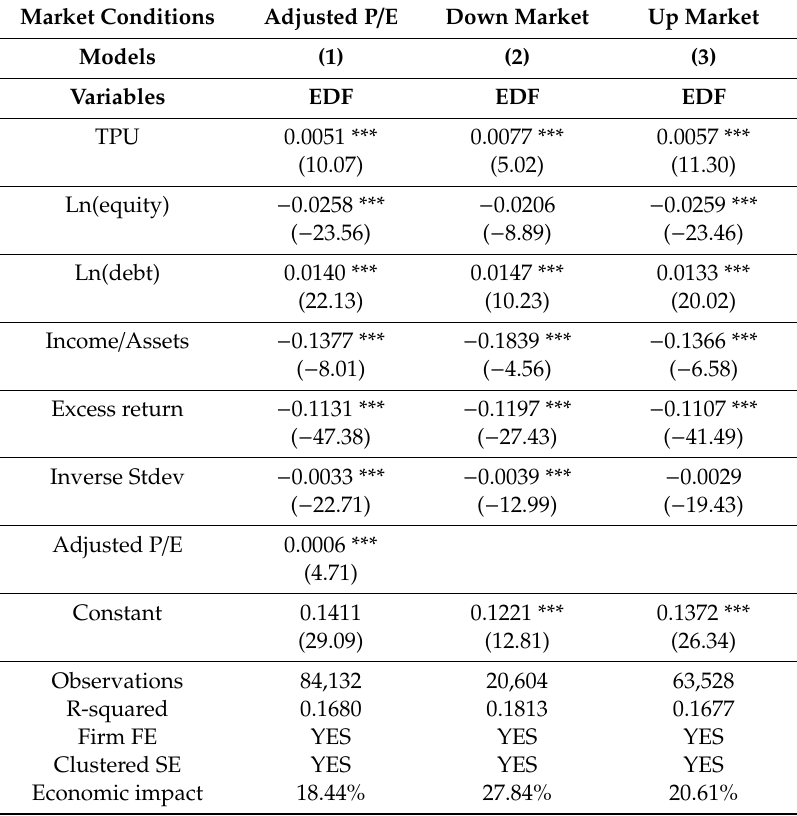
Table 4. Impact of tax policy uncertainty on default risk conditioned on stock market conditions—This table presents firm fixed e ff ects regression results for the impact of tax policy uncertainty on default risk. The sample has 9888 unique firms from 1987 to 2019. In all models, the dependent variable is the expected default frequency ( EDF ). The main variable of interest tax policy uncertainty (TPU). All variables are defined in Appendix A. We proxy the stock market conditions similar to (P á stor and Veronesi 2013). Specifically, we obtain the cyclically adjusted price-to-earnings ratio for the aggregate stock market (P / E), downloaded from Robert Shiller’s website. The down-market binary variable is set equal to one if the CRSP value-weighted market index annual return is less than zero, zero otherwise. The economic impact panel reports the economic impact of a standard deviation increase in TPU on default risk on a relative basis. T -statistics reported in parentheses are calculated using standard errors that are clustered at the firm level and are robust to heteroskedasticity. Symbols *** indicate statistical significance at 10%, 5%, and 1% levels,